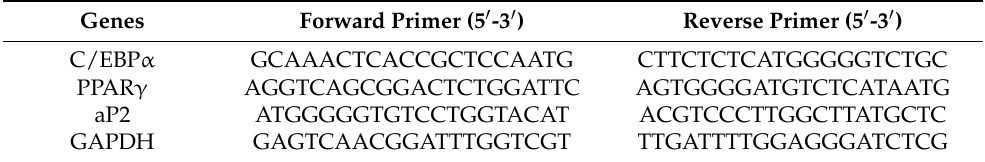
Table 2. Primer sequences used for mRNA expression.